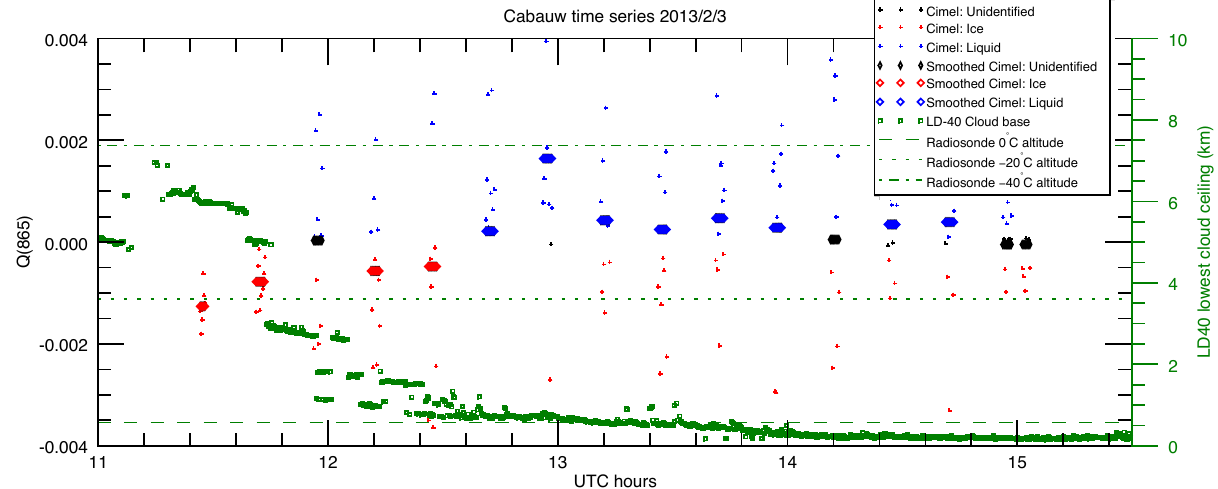
Figure 11. Cimel polarized zenith radiance and Vaisala LD-40 ceilometer data from 3 February 2013, at the CESAR site. Local noon was at 13:00UTC. Ceilometer data (green) indicate high-altitude (ice) clouds until about 12:00UTC, when low-altitude (water) clouds appeared. Cimel data (tagged in blue for liquid, red for ice, black otherwise) show little indication of cloud phase. Smoothed data (averages within a 10min moving window) do a slightly better job of indicating cloud phase and are indicated by blue, red, and black diamonds. A radiosonde launched at the Royal Netherlands Meteorological Institute (EHDB) in De Bilt, roughly 25km northeast of CESAR, found temperatures of 0 ◦ C at 570m, − 20 ◦ C at 3600m, and − 40 ◦ C at roughly 7.4km. 2D histogram for Q & cloud base, 40 ° < (cid:101) < 70 °